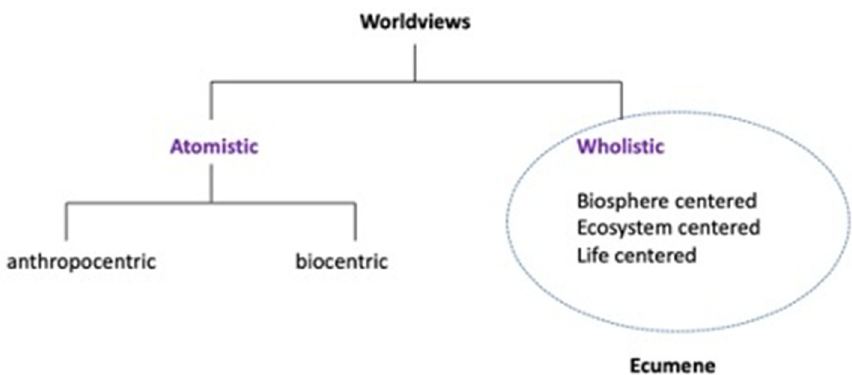
Figure 2. Worldviews are the foundations of how humans perceive, interpret, use, and value the constituents of their habitat according to cultural predispositions, social norms, and individual preferences. Anthropocentric worldviews position humans as the central and most important constituent of planet Earth, especially in relation to all animals and plants. Human experience, motives and values override the existence and intrinsic value of all other living organisms. Biocentric worldviews uphold that all forms of life on Earth have intrinsic value that are equal and should not be prioritized. Hence humans are not in a superior position to all other living organisms. Understanding and protecting species rather than ecosystems is the main concern. Ecocentric worldviews are wholistic and they regard all the components of ecosystems as contributors to life on Earth, rather than considering each component as a resource for human use or protection. Ecocentrism proposes an ethical framework and moral values that reject anthropocentric views about relations between humans and all other species.This diagram shows the core difference between atomistic and wholistic worldviews, and it locates ecumene in the second category. (Source: Author).